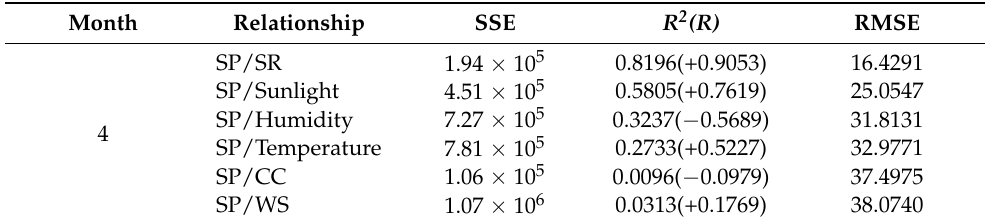
Table 1. Performance comparison of solar power vs. meteorological factors. Bolded values are the best in the comparison.